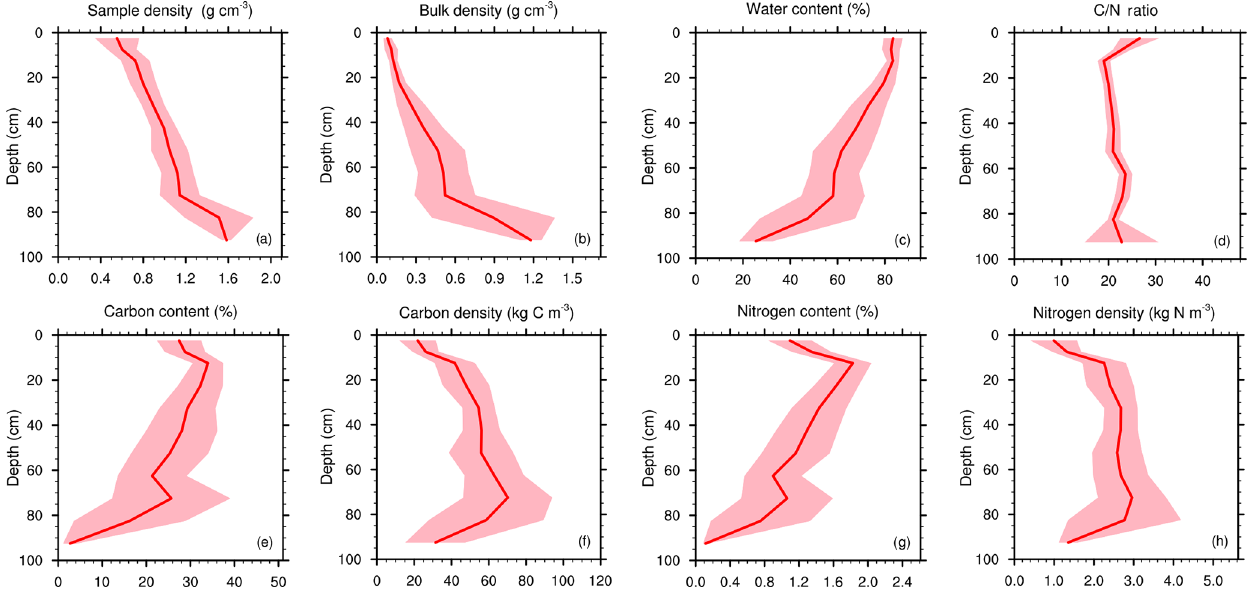
Figure 7. Mean soil profiles over both transects ( n samples = 135; n profiles = 17) of (a) soil sample density ρ sample (gcm − 3 ), (b) soil bulk density ρ obs (gcm − 3 ), (c) soil water content (%), (d) C / N ratio (–), (e) soil carbon content f C (%), (f) soil carbon density ρ C (kgCm − 3 ), bulk (g) soil nitrogen content f N (%), and (h) soil nitrogen density ρ N (kgNm − 3 ). The shaded area represents the 95% confidence